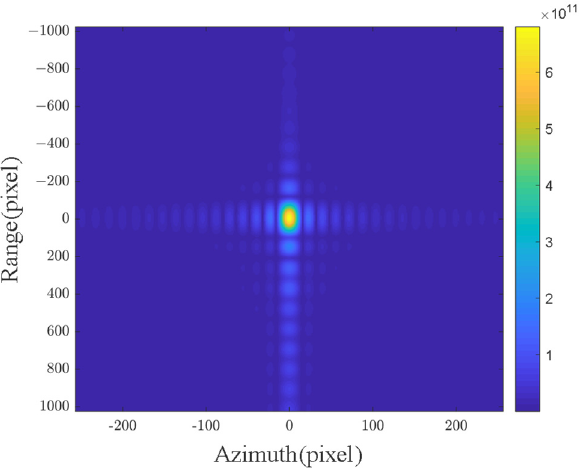
Figure 7. The imaging results of the point target.